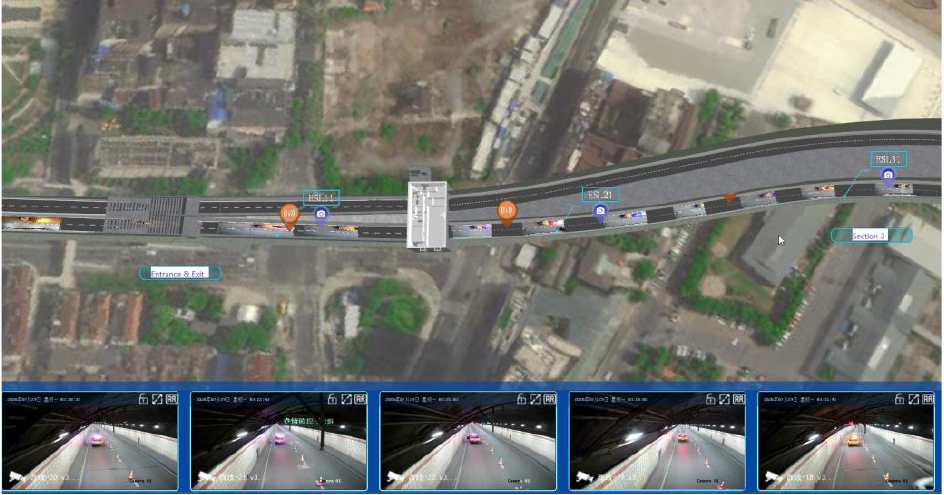
Figure 11. Tunnel virtual top view display.